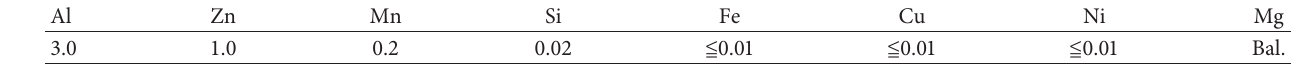
Table 1: The chemical composition of AZ31 magnesium alloy (wt.%).